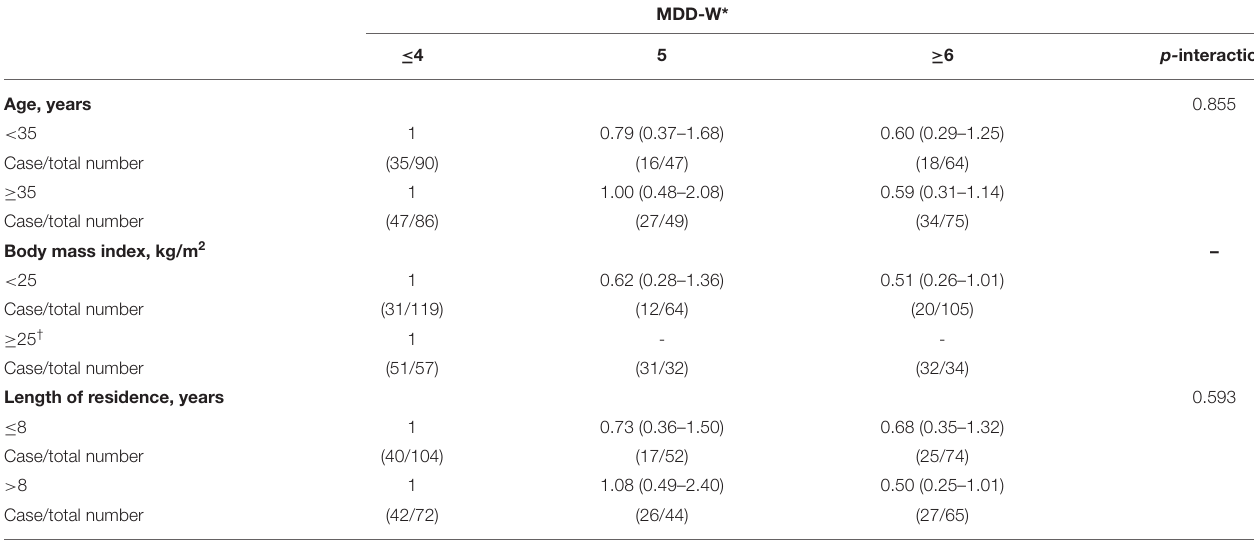
TABLE 5 | Subgroup analysis of the association of MDD-W with waist circumferences in the FiLWHEL